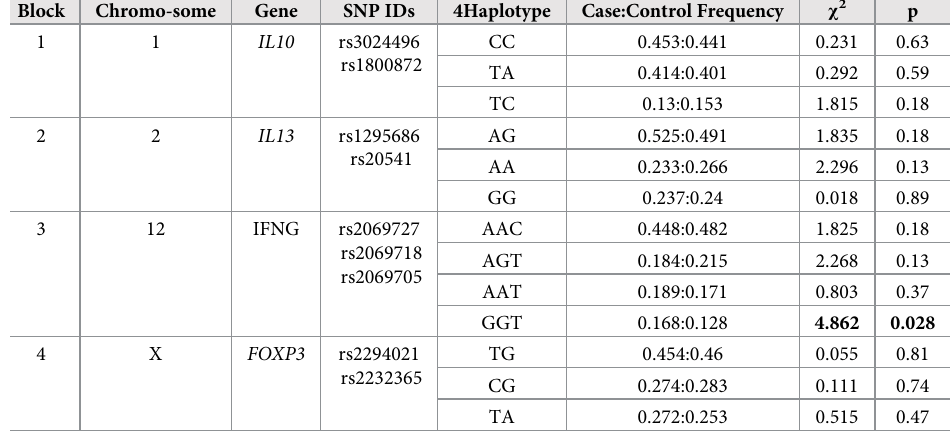
Table 4. Case-control analysis of haplotype frequencies between schistosome-infected (N = 354) and–uninfected individuals (N = 442). Block Chromo-some Gene SNP IDs 4Haplotype